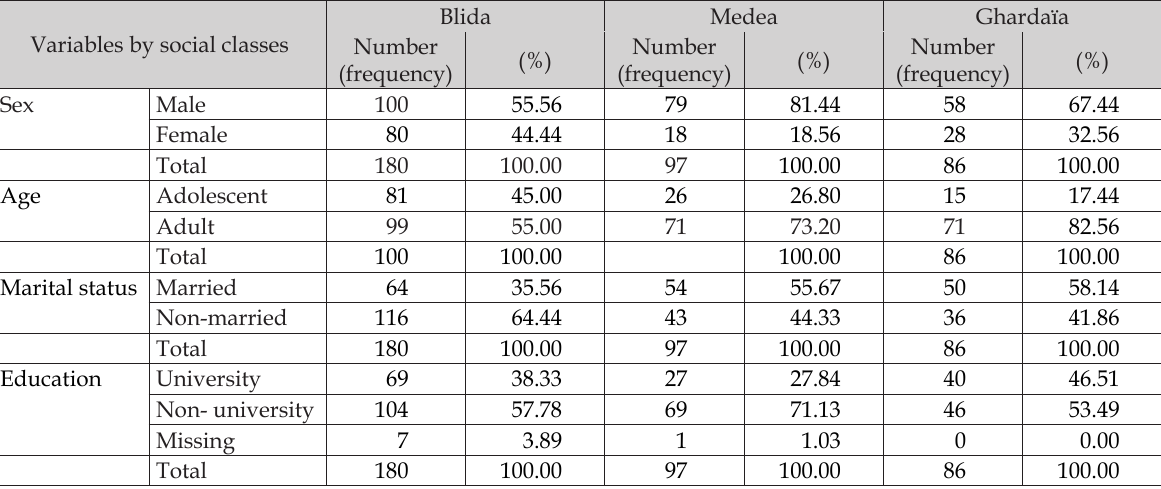
Table 1. Socio-demographic structure of the